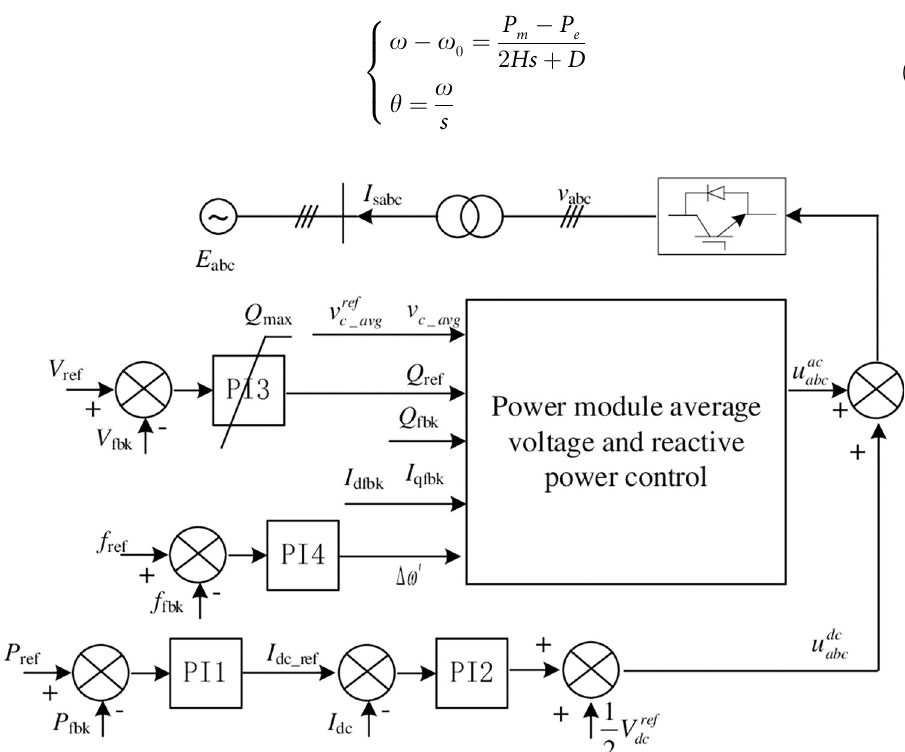
Fig 6. Constant active power control structure based on VSG